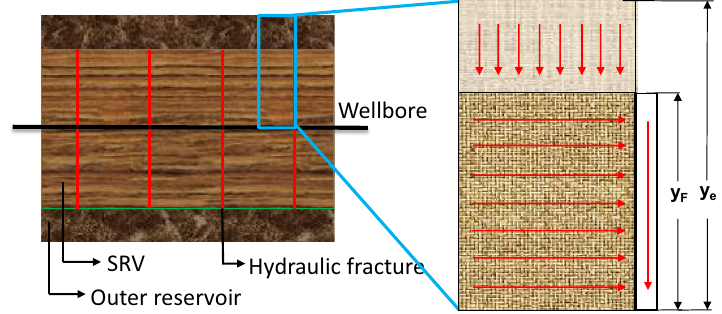
Fig. 1 Schematic of the trilinear model for a hydraulically frac- tured shale oil well